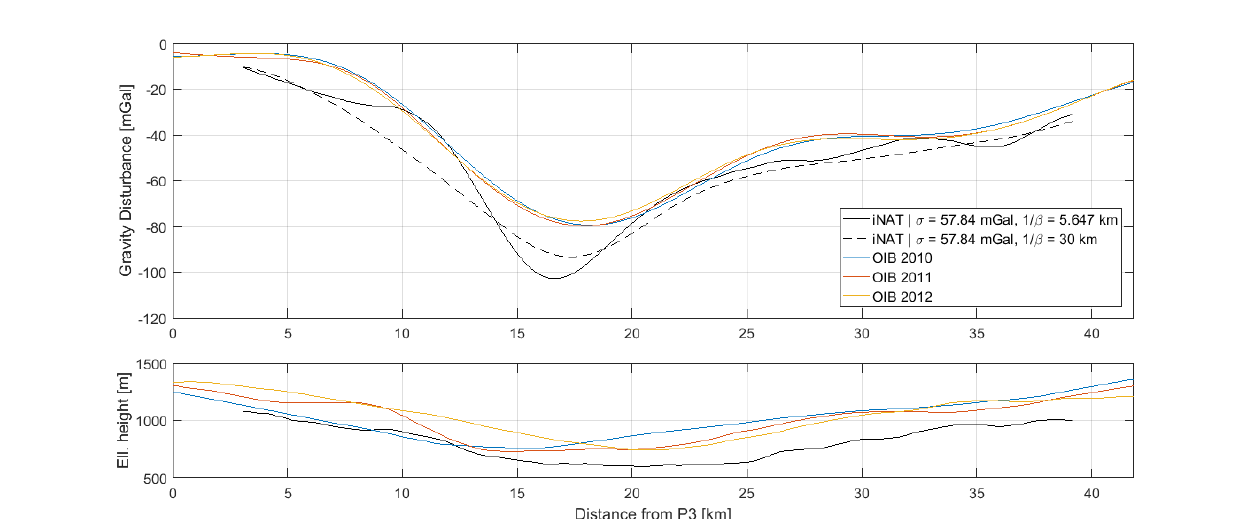
Figure 7. Gravity disturbance estimates for the profile between P3 and P4 for two different Gauss–Markov correlation lengths: ( top ) gravity disturbance profile; ( bottom ) height profile.